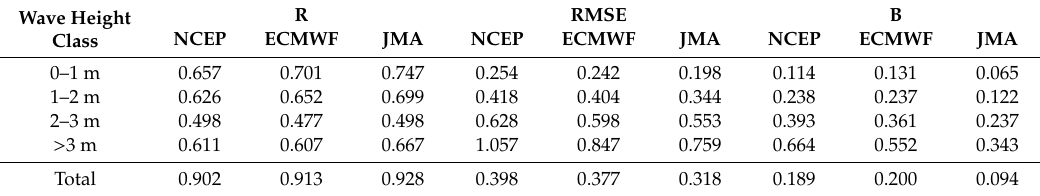
Table 5. Wind product verification results for wave height